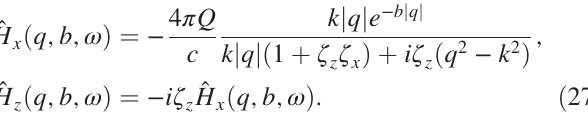
FIG. 5. Numerically calculated ratio of Joule loss into metal to wake loss of a point charge beam, u function of w= ð 2 a Þ (plotting symbols). The wake loss for a point ¼ Q 2 π 2 = ð 8 a 2 Þ particle is u w